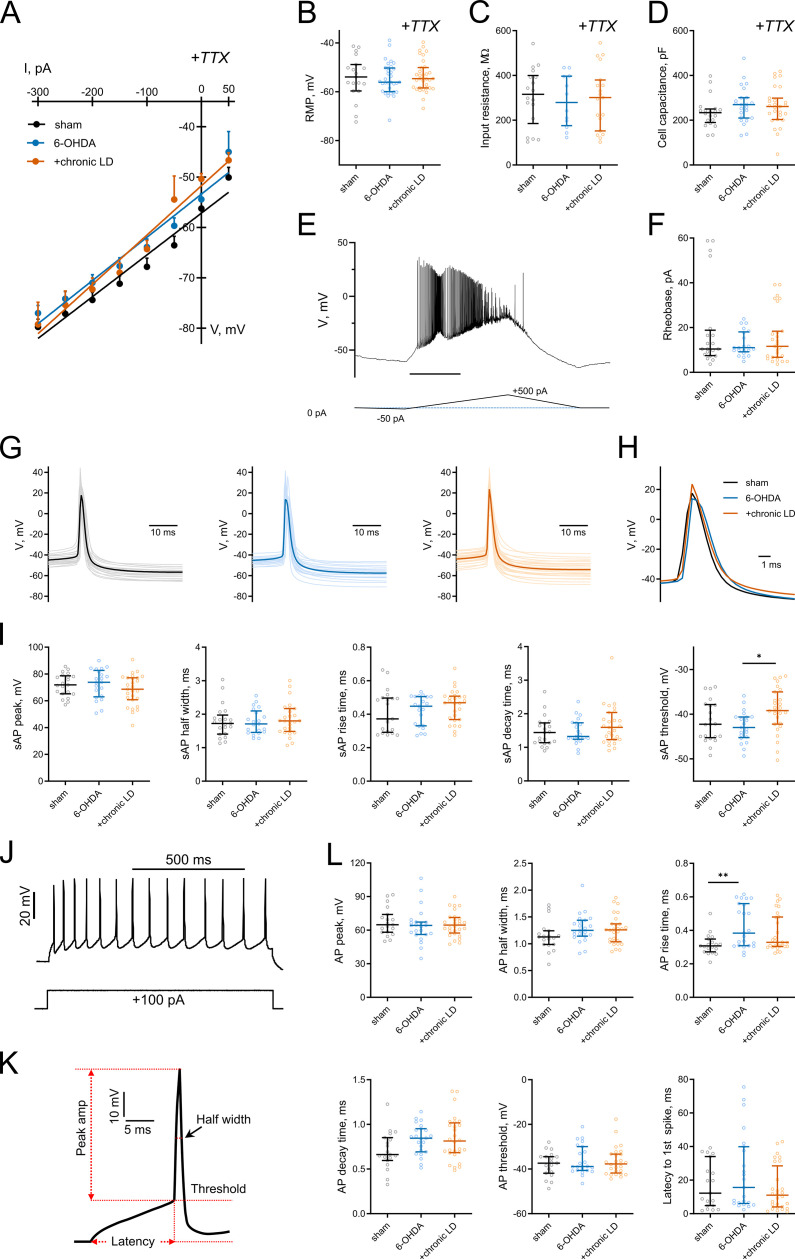
Basic electrophysiological characteristics in ChIs from control, 6-OHDA, and chronic LD mice.(A) Voltage-current dependence, (B) resting membrane potential, (C) input resistance, (D) membrane capacitance and (F) rheobase were unchanged in 6-OHDA and chronic-LD groups. (E) Ramp protocol for rheobase determination. Recordings in A-D were recorded in whole-cell mode in the presence of 1 µM TTX (n = 12–34 neurons/4–9 mice per group). (G) Representative and (H) averaged traces and shape characteristics (I) of sAPs from the three experimental groups (n = 21–27 neurons/8–10 mice per group). (J) Current protocol (lower) and representative trace (upper) of action potentials evoked by 100 pA current injection. (K, L) Shape characteristics of action potentials evoked by 100 pA current injection (n = 19–28 neurons/8–11 mice per group). p<0.05 (*) or p<0.01 (**) by Kruskal-Wallis test with Dunn’s multiple comparison analysis. Exact n for each figure are listed in Figure 1—source data 1.